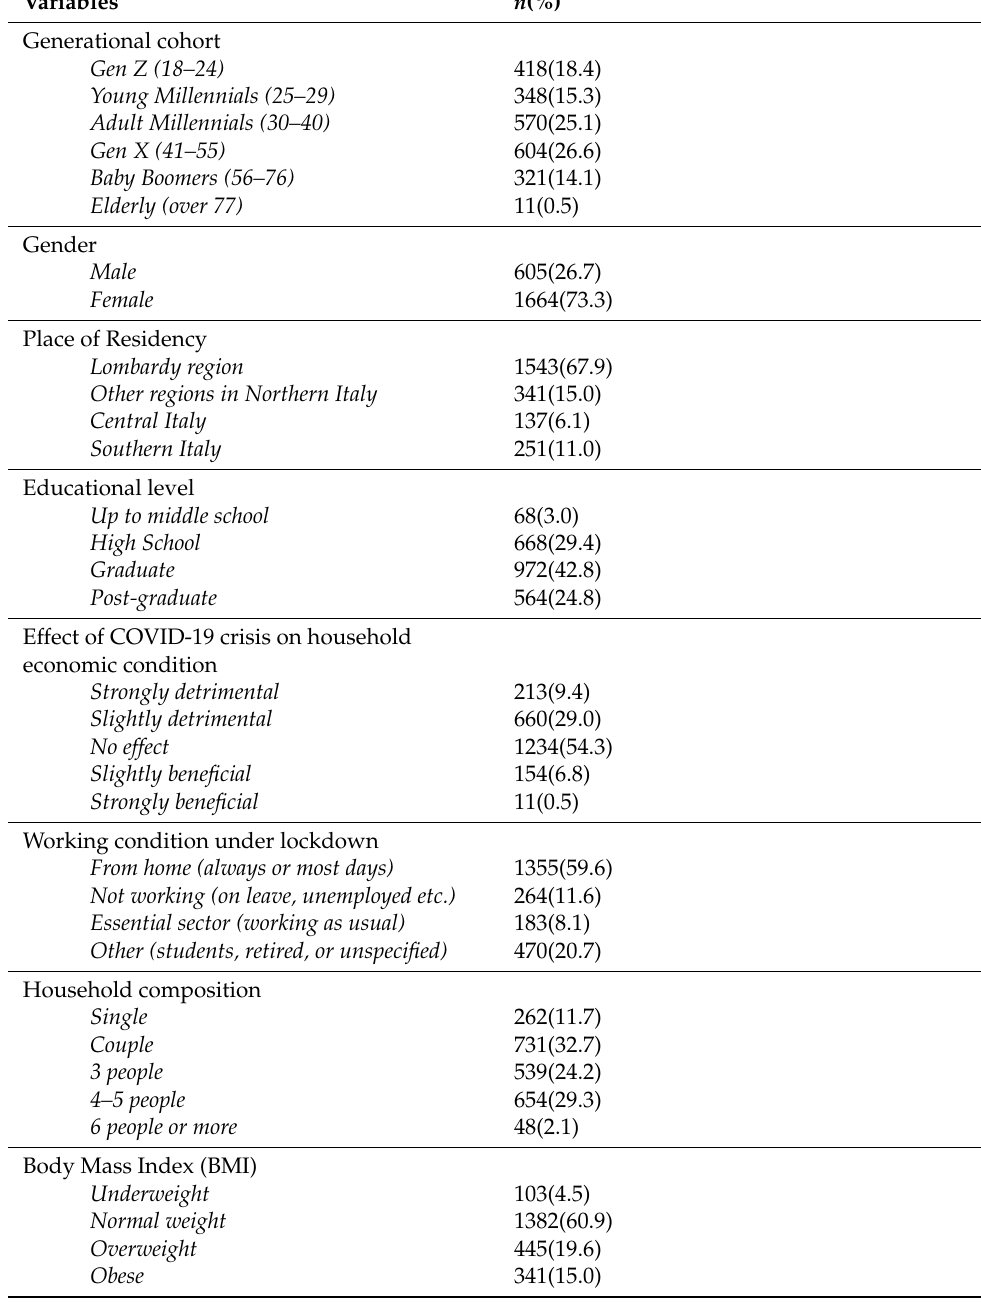
Table 1. Socio-demographic, household, and clinical characteristics of the study sample ( n =